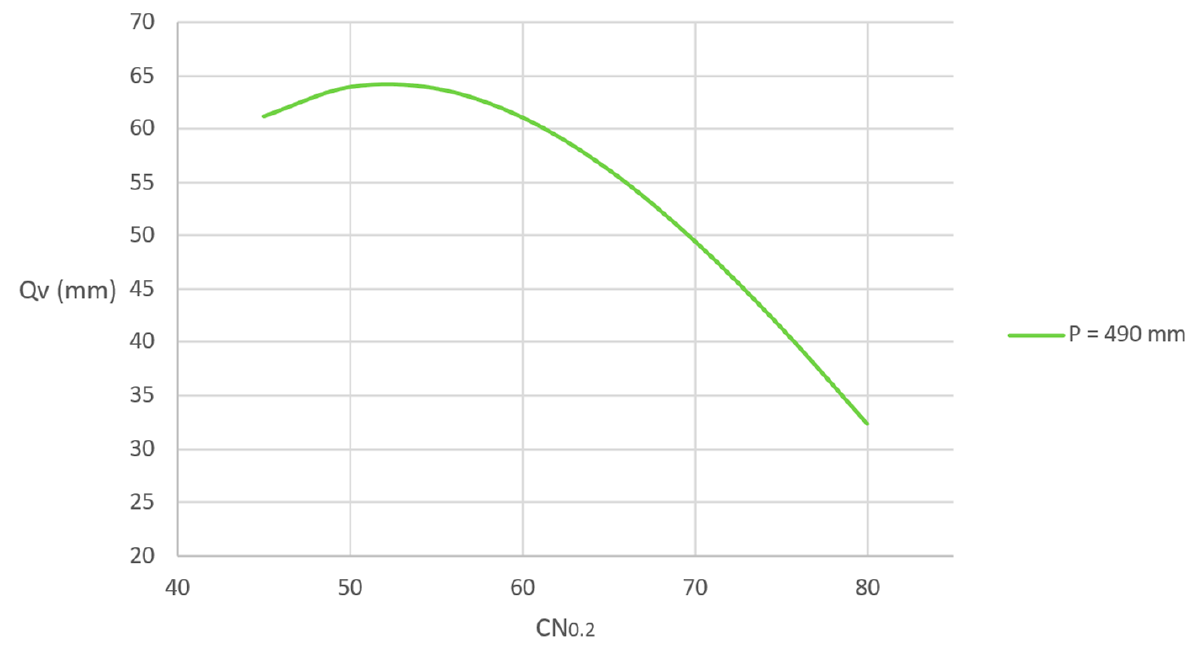
Figure A1. The runoff difference between the conventional SCS-CN rainfall runoff model and the Figure A1. The runo ff di ff erence between the conventional SCS-CN rainfall runo ff model and the calibrated model across different CN 0.2 values in Peninsular Malaysia during the 1970s. Note: 490 mm calibrated model across di ff erent CN 0 . 2 values in Peninsular Malaysia during the 1970s. Note: 490 is the highest recorded rainfall amount in Peninsular mm is the highest recorded rainfall amount in Peninsular Malaysia.